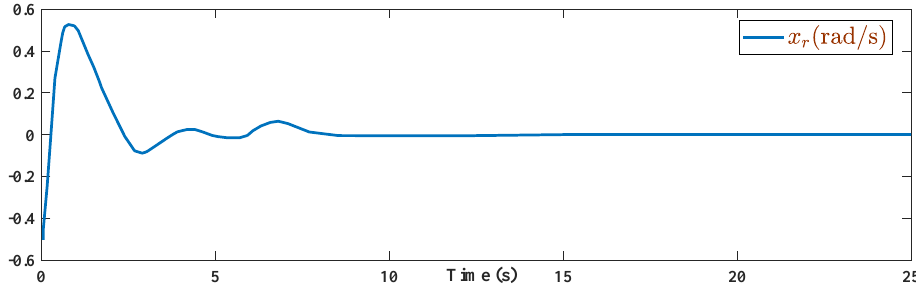
Figure 3. Time response of x r related to Scenario 1.